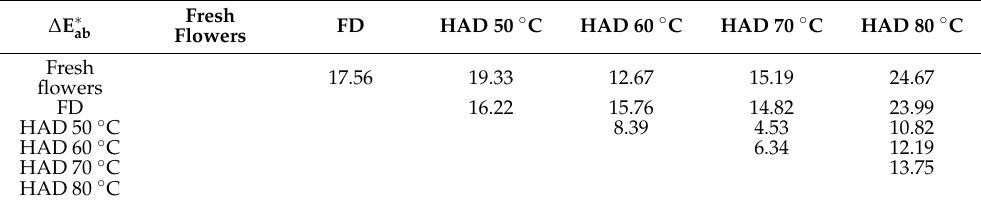
) among flowers ab